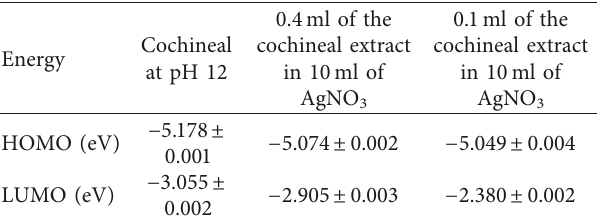
Figure 6: Cyclic voltammogram of cochineal pigment and AgNPs synthesized from 0.1 and 0.4 ml of the cochineal extract. SHE (cid:31) saturated hydrogen electrode; SCE saturated calomel electrode. (cid:31) Table 4: Energy levels of cochineal pigment (pH 12.0) and AgNPs (0.1 and 0.4ml of the cochineal